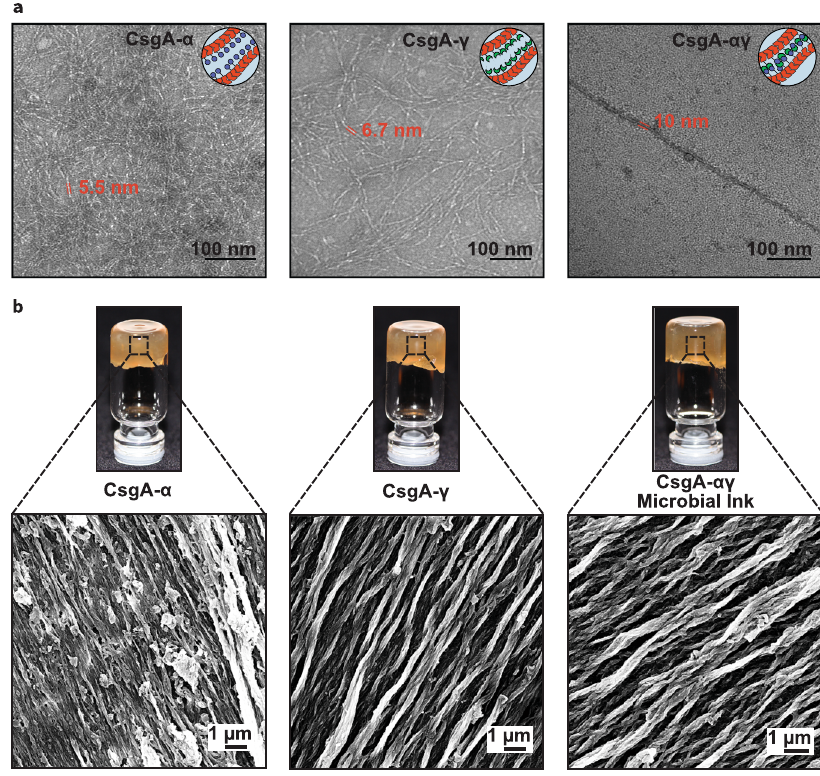
Fig. 2 Optical and electron microscopy images of functional curli nano fi bers and the corresponding hydrogels. a Transmission electron microscope (TEM) images of self-assembled nano fi bers of CsgA- α , CsgA- γ and CsgA- αγ (co-culture of CsgA- α and CsgA- γ ) after recombinant expression. Representative images from three independent samples were reported. b Optical images of CsgA- α , CsgA- γ and microbial ink CsgA- αγ hydrogels with the corresponding fi eld-emission scanning electron microscope (FESEM) images show the presence of aligned microscopic fi ber bundles. Representative images from three independent samples were